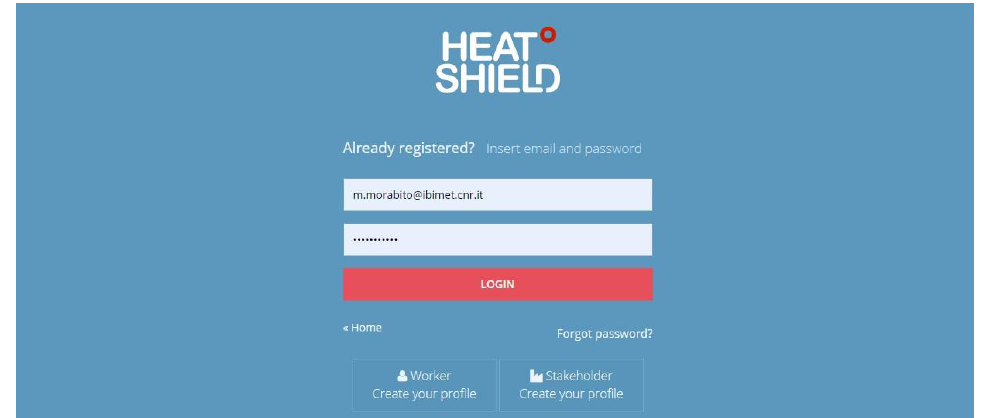
Figure 3. Registration page to access the personalized HEAT-SHIELD occupational warning system outputs.